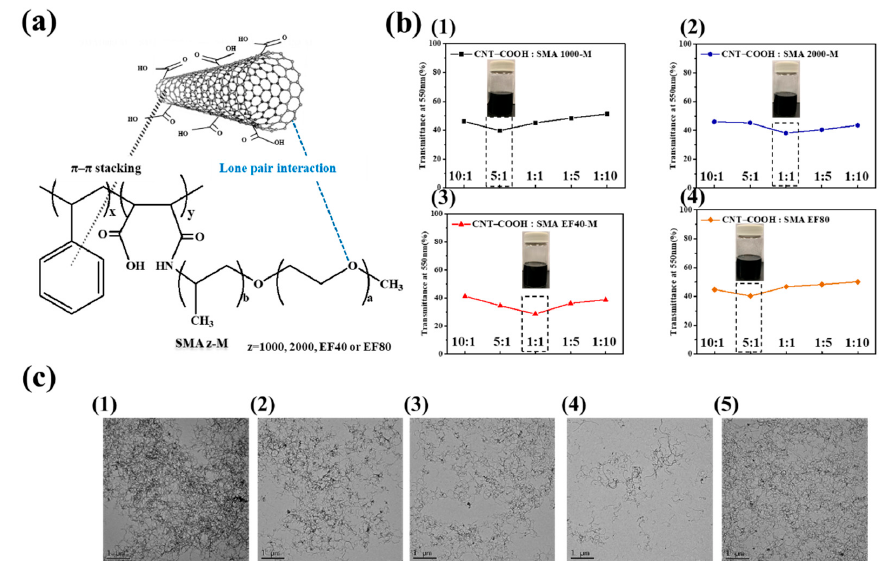
Figure 5. ( a ) Schematic of the dispersion mechanism of CNT–COOH by polymeric dispersant. ( b ) Transmittance of CNT–COOH with different polymeric dispersants in different proportions at a wavelength of 550 nm. ( c ) TEM images of ( 1 ) no polymeric dispersant added, ( 2 )